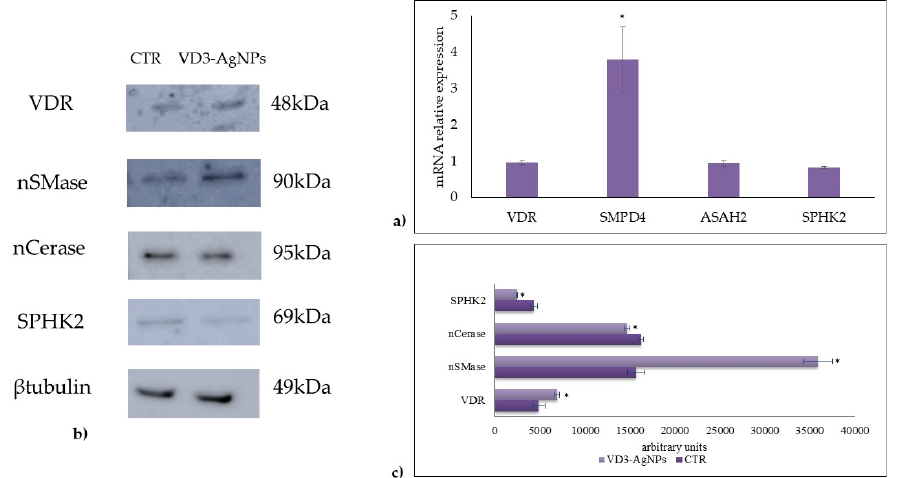
Figure 4. Effect of VD3 + AgNPs on gene and protein expression in HaCaT cells. Cells were cultured and treated as reported in Section 4. ( a ) Gene expression evaluated by RT-PCR; glyceraldehyde 3-phosphate dehydrogenase and 18S rRNA were used as housekeeping genes. ( b ) Western blotting; the position of proteins was indicated in relation to the position of molecular size standards, β -tubulin was used as loading control. ( c ) Area density evaluated by Chemidoc Imagequant TL software. VDR, vitamin D3 receptor; nSMase neutral sphingomyelinase; nCerase, neutral ceraminidase; and SPHK2, sphingosine kinase 2. Values of proteins, normalized with β -tubulin, are expressed as arbitrary units in control and experimental sample (treated with 133 nM VD3 + 5 ppm AgNPs) and represent the mean ± SD of three independent experiments performed in duplicate. Significance, * p < 0.05 versus the control sample.